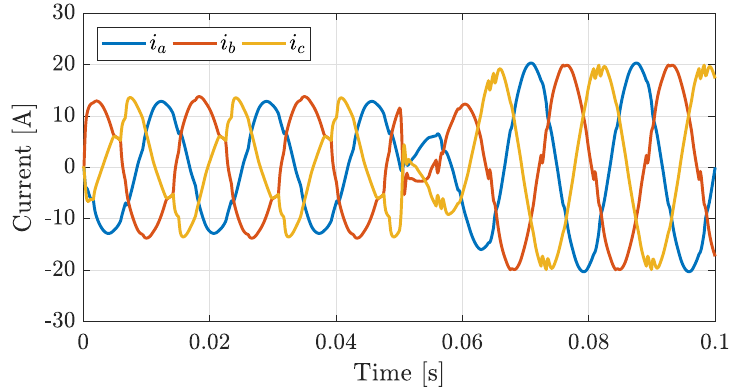
Figure 10. Current correction by the hybrid PI-LQR control action under unbalanced nonlinear load conditions.